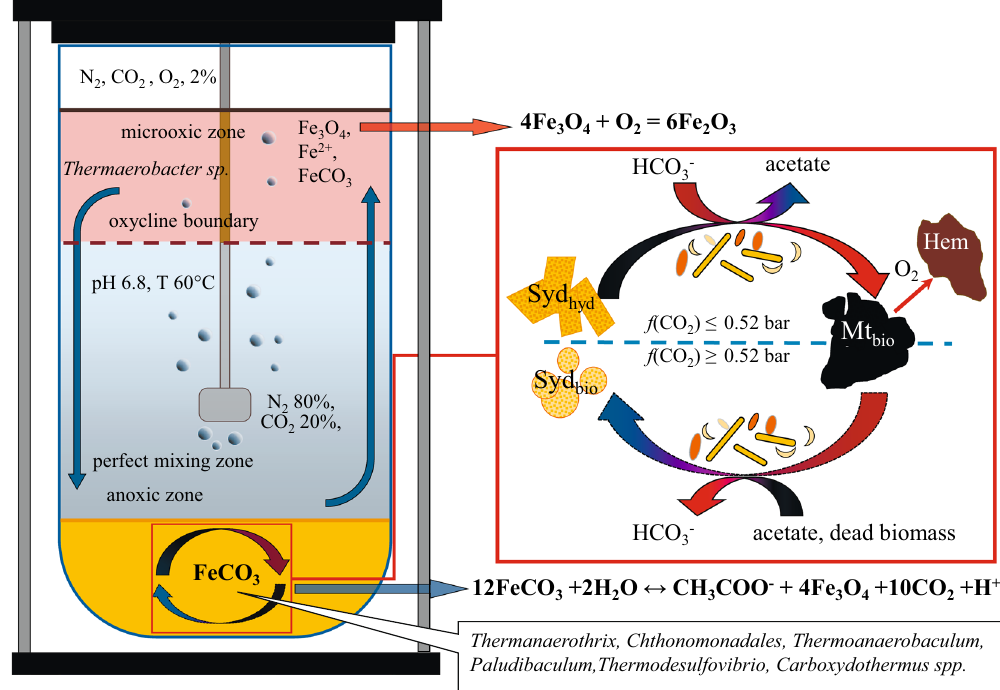
Figure 5. Schematic representation of the proposed processes in the bioreactor culture . Sid hyd hydrothermal siderite, Sid bio metabolically induced siderite, Mt bio metabolically induced magnetite, Hem hematite, red square anaerobic iron cycle driven by the thermophilic microbial consortium at the bottom of the bioreactor (in the mineral